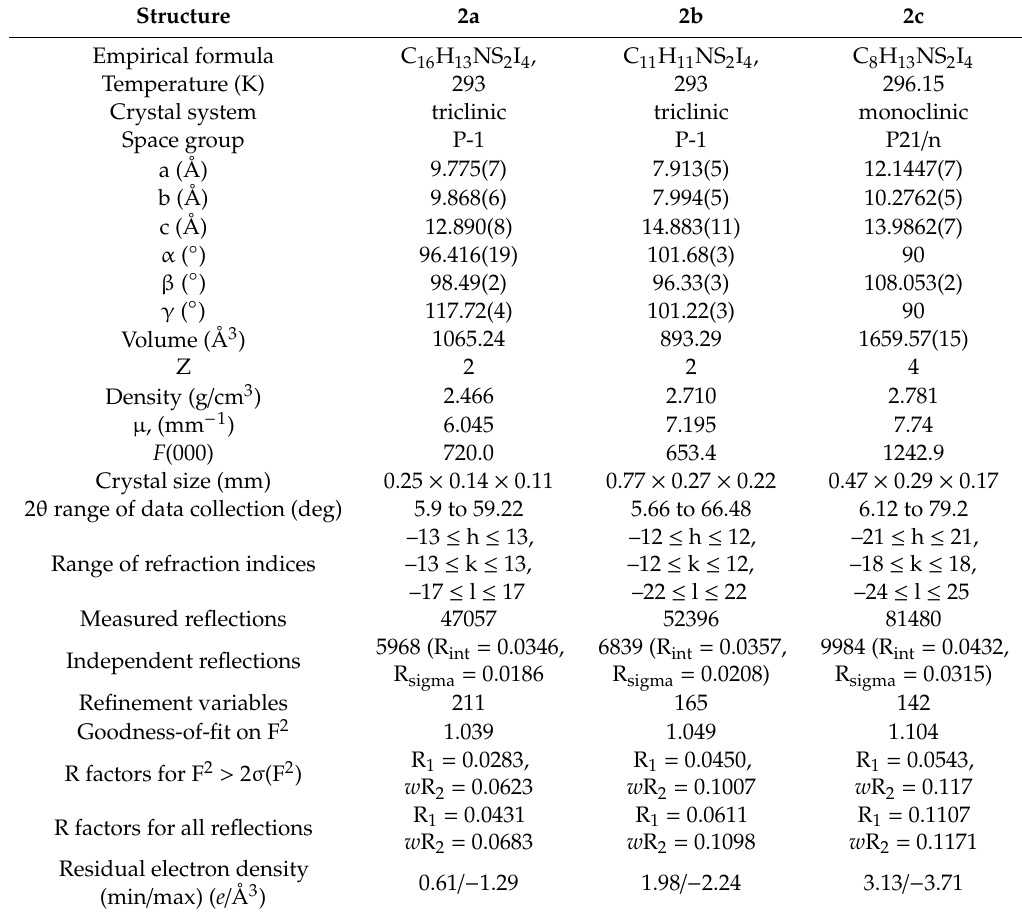
Table 1. Crystal data and structure refinement for triiodides